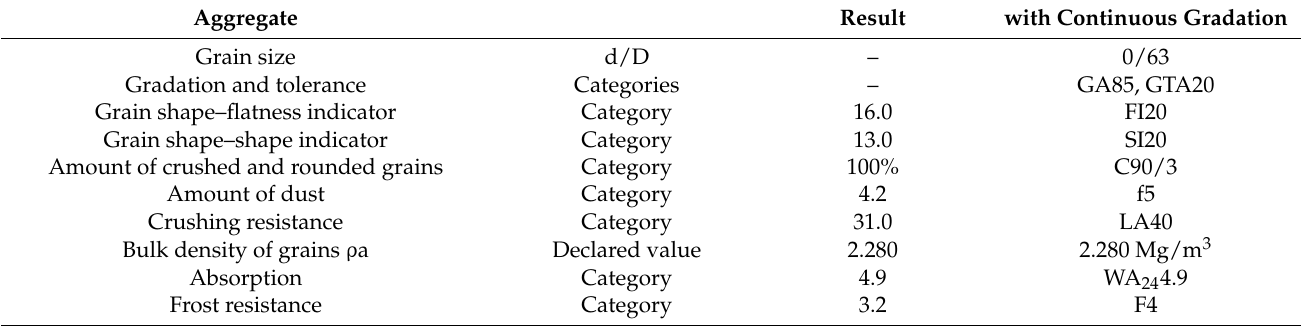
Table 3. Properties of recycled cement concrete (RC).